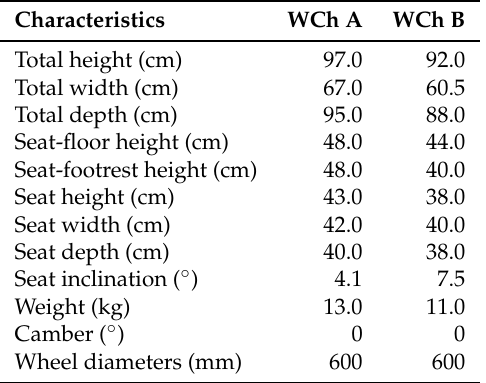
Table 1. Wheelchairs (WCh) used for the experimental protocol.